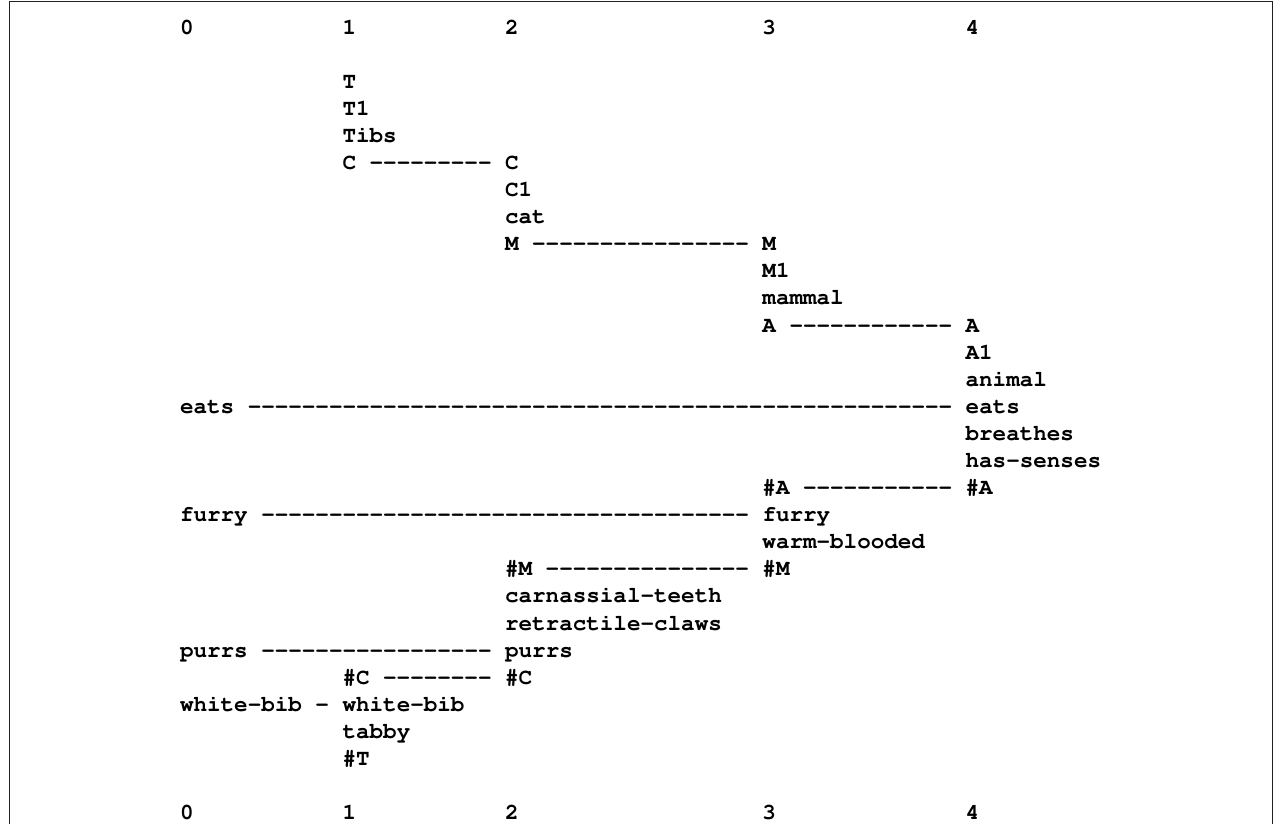
FIGURE 6 | The best multiple alignment found by the SP computer model with four one-symbol New patterns representing attributes of an unknown creature and a collection of Old patterns representing different creatures and classes of creature. Adapted from Figure 6.7 in Wolff (2006), with permission.